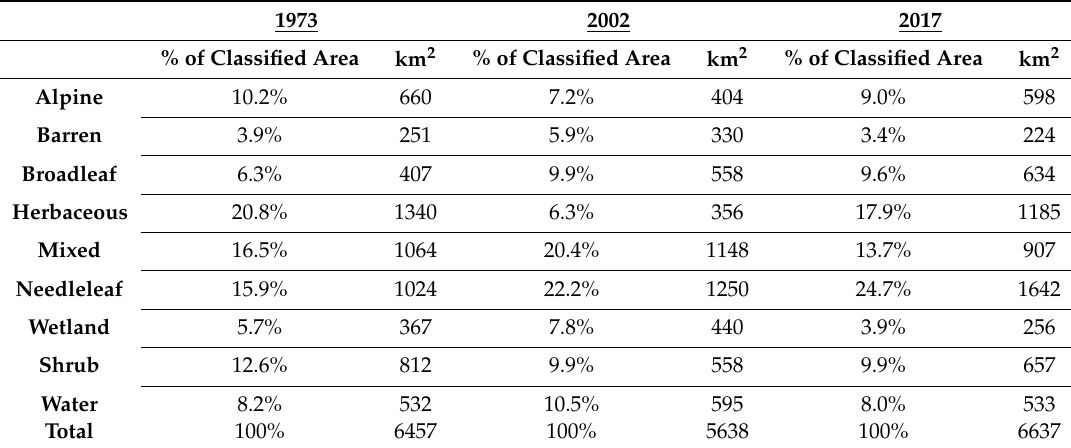
Table 5. Estimated area for each land-cover type based on model classification with 50% or greater probability.